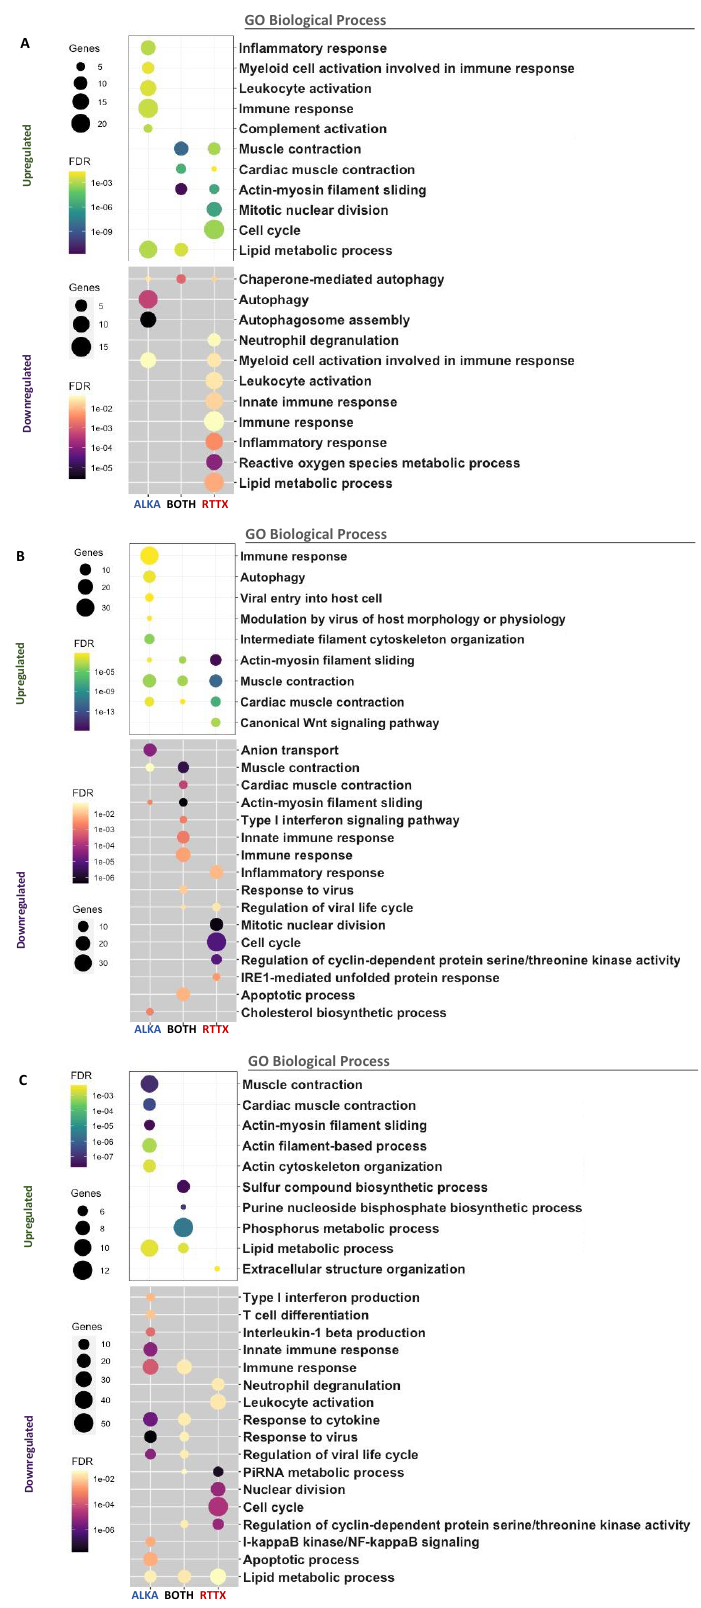
Figure 2. Functional enrichment analysis of differentially expressed genes in fish challenged with RTTX and ALKA at days 1 ( A ), 7 ( B ), and 20 ( C ) post-challenge. Up- and downregulated genes